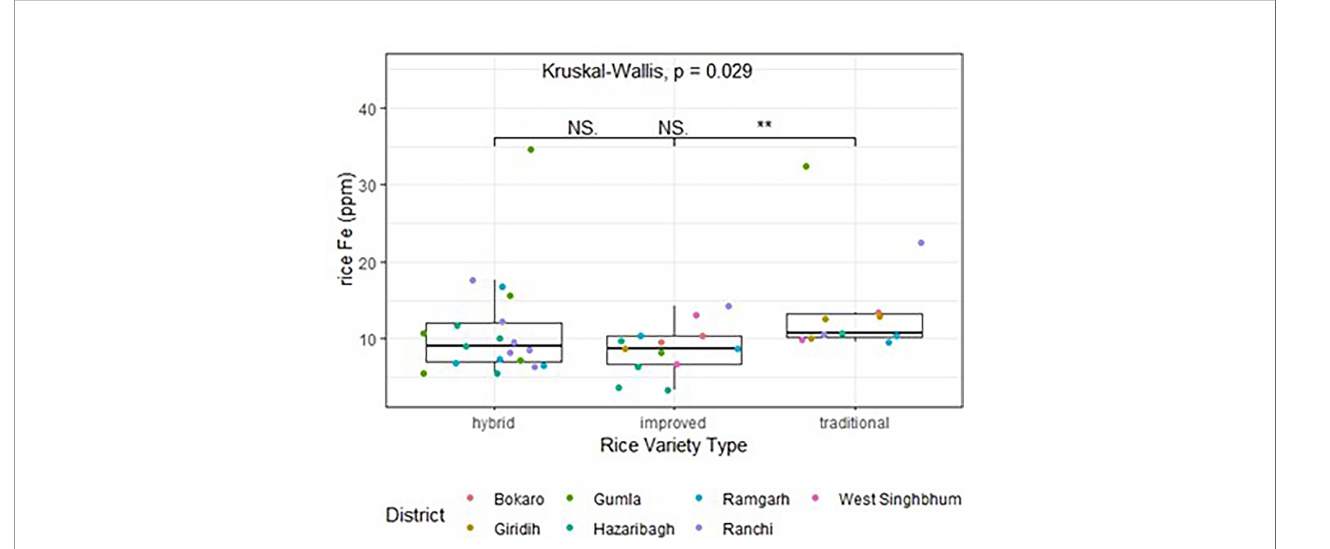
FIGURE 6 | Rice Fe concentrations in hybrid, improved and traditional rice varieties. NS: not signi fi cant; * signi fi cant at the 0.05 signi fi cance level; ** signi fi cant at the 0.01 signi fi cance level; *** signi fi cant at the 0.001 signi fi cance